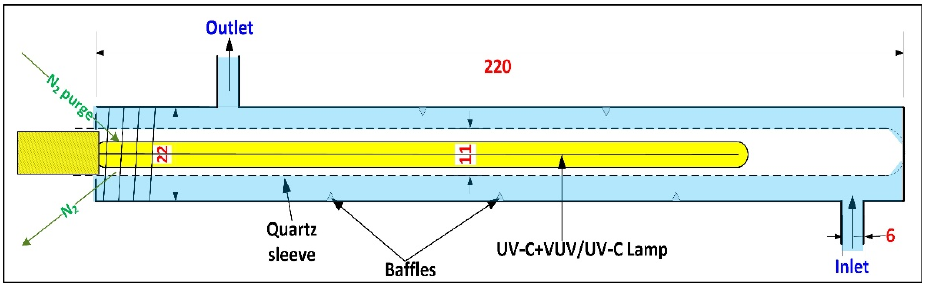
Figure 6. A scheme of the continuous-flow photoreactor (after [21]).